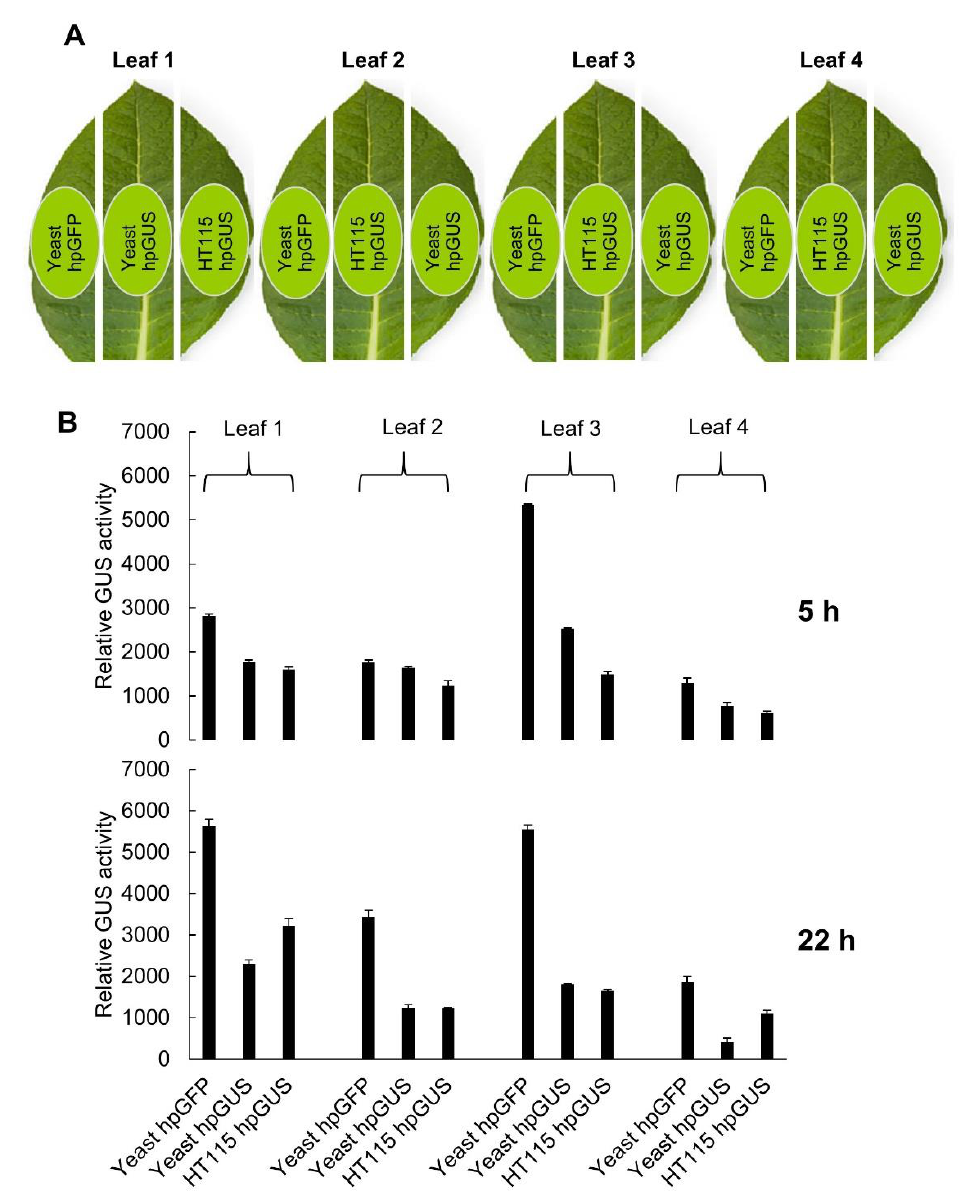
Figure 4. hpRNA expressed in yeast can induce exogenous RNAi against the GUS reporter gene in tobacco leaves. hpGFP RNA from yeast and hpGUS RNA from HT115 containing the 35S-driven hpGUS-1 construct were used as controls. ( A ) Illustration of three cut leaf sections, of which a ~2 cm 2 area in the middle (highlighted in light green) was brushed with the three different RNA samples as specified. ( B ) Relative GUS activity measured using 4-methylumbelliferyl-β- D -glucuronide (MUG) assay with three technical replicates for each sample. Note that the relative effect on GUS expression of yeast derived RNA over HT115-derived RNA increased from the 5 h time point to the 22 h time point. The same assay was performed on four separate leaves.